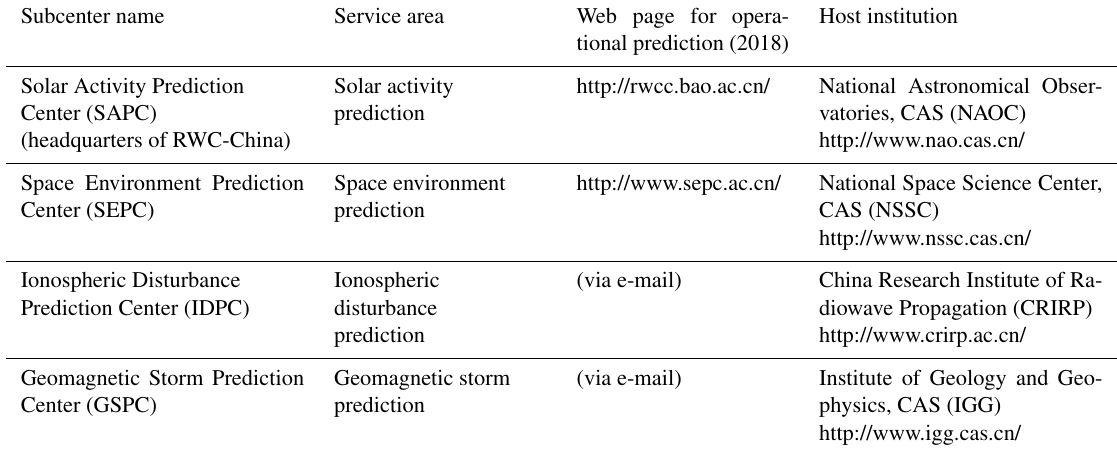
Table 1. Four subcenters of RWC-China.